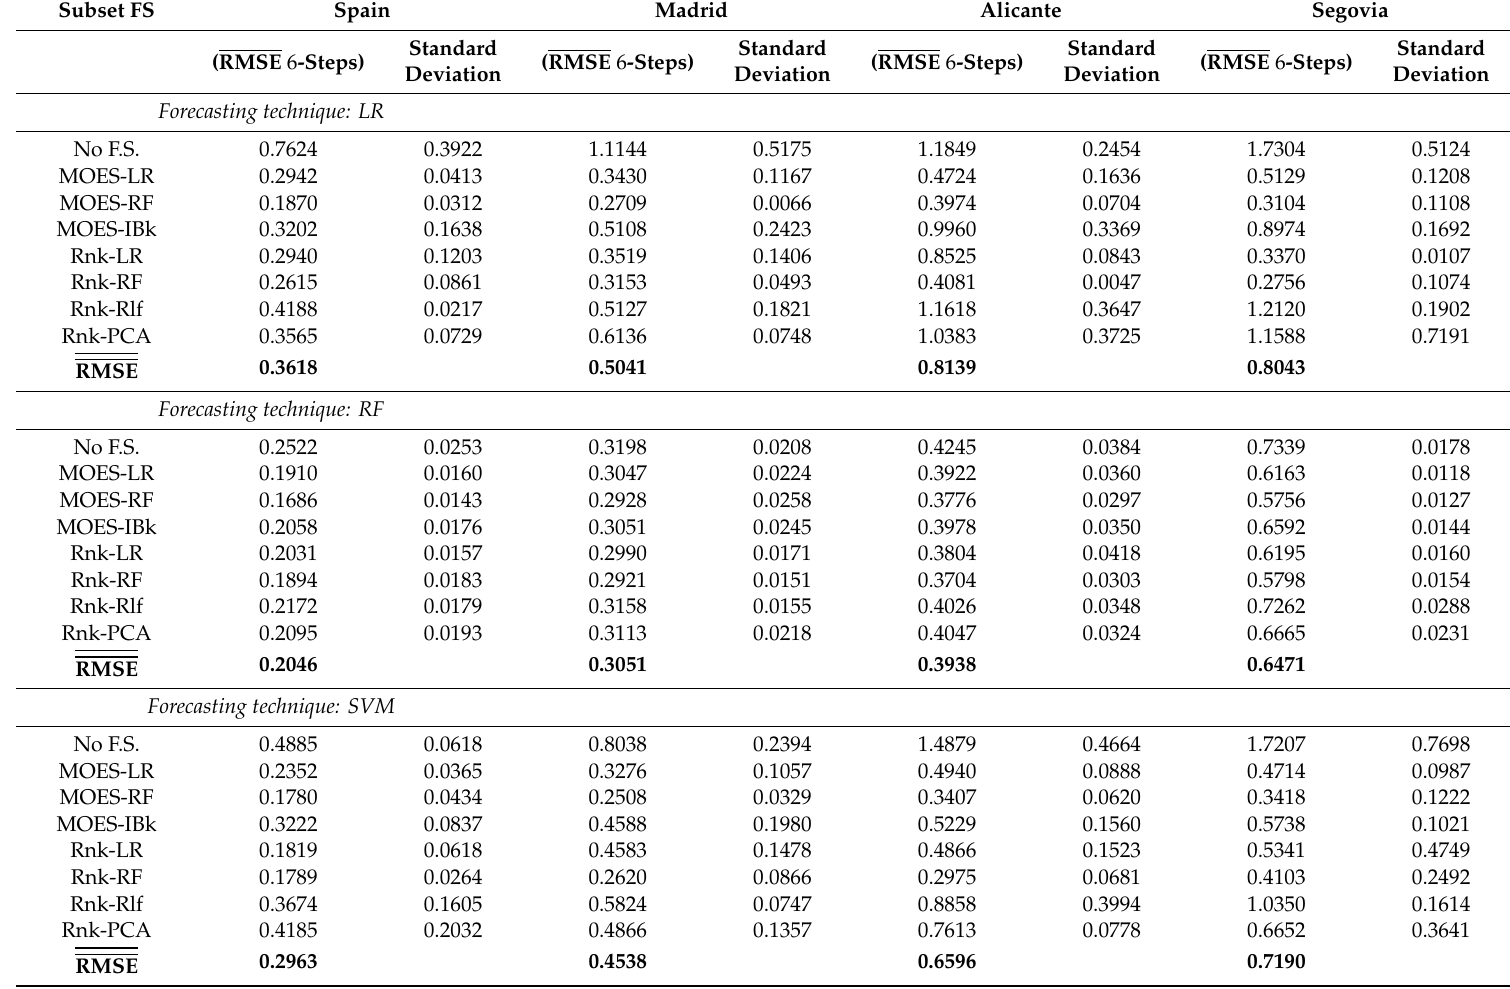
Table 6. Average RMSE to 6-step GBV complaints forecasting in di ff erent